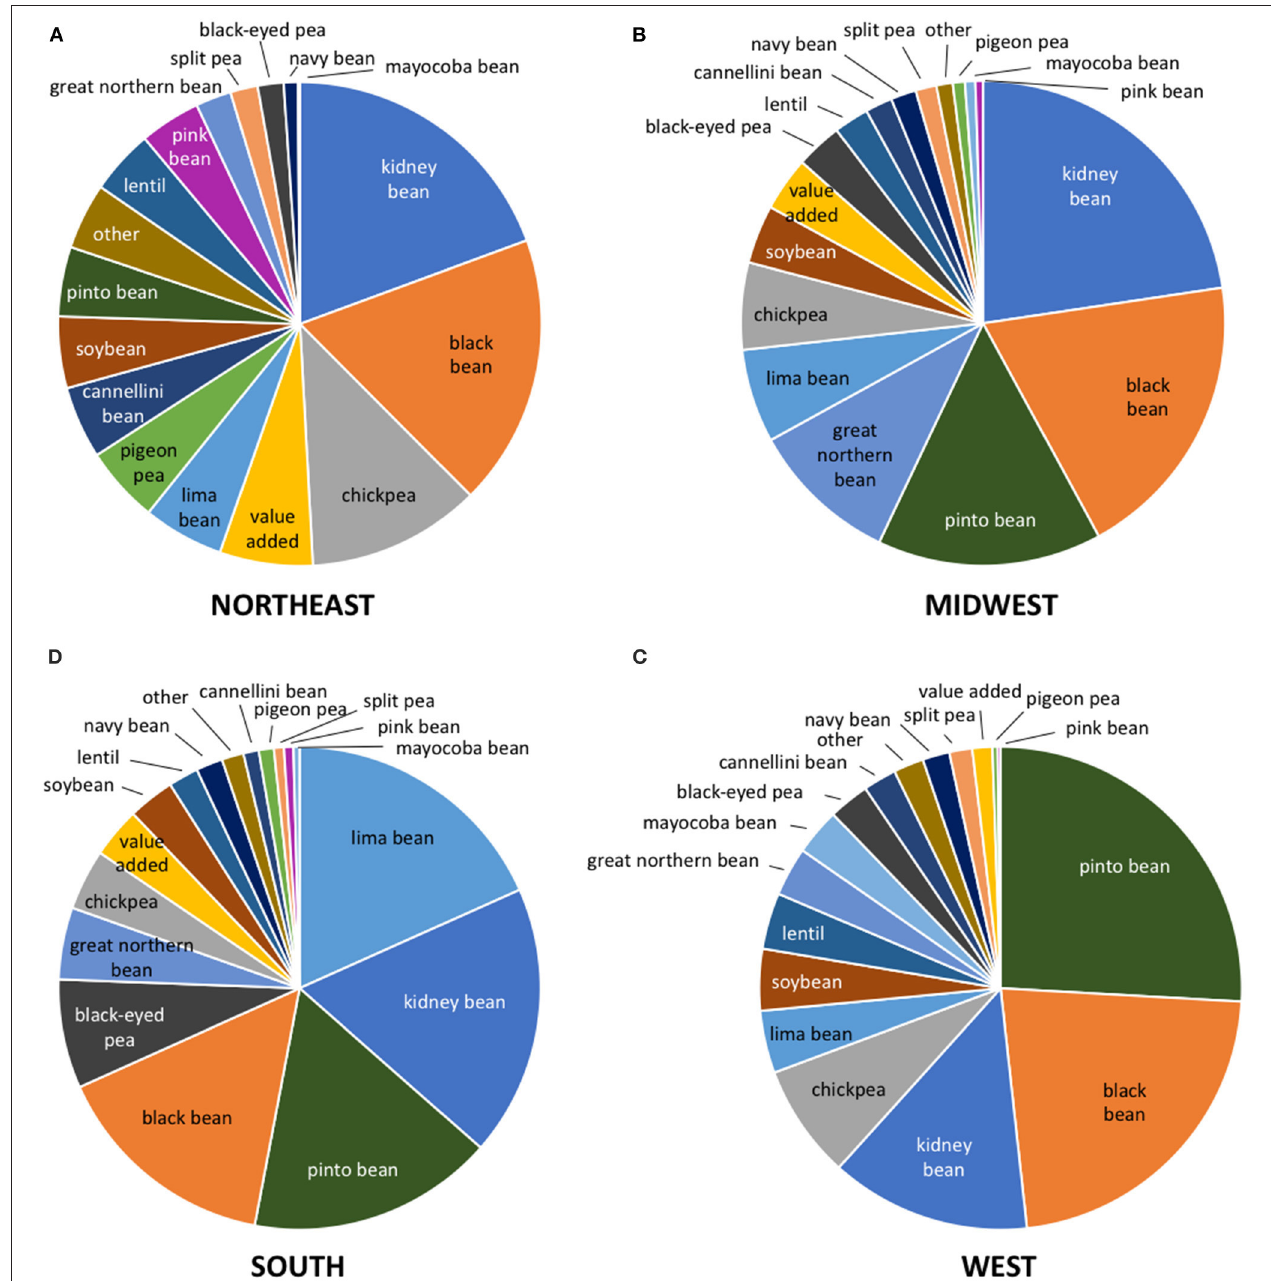
FIGURE 3 | Per capita expenditure on type of legume by region of US: (A) Northeast, (B) Midwest, (C) West, (D) South.